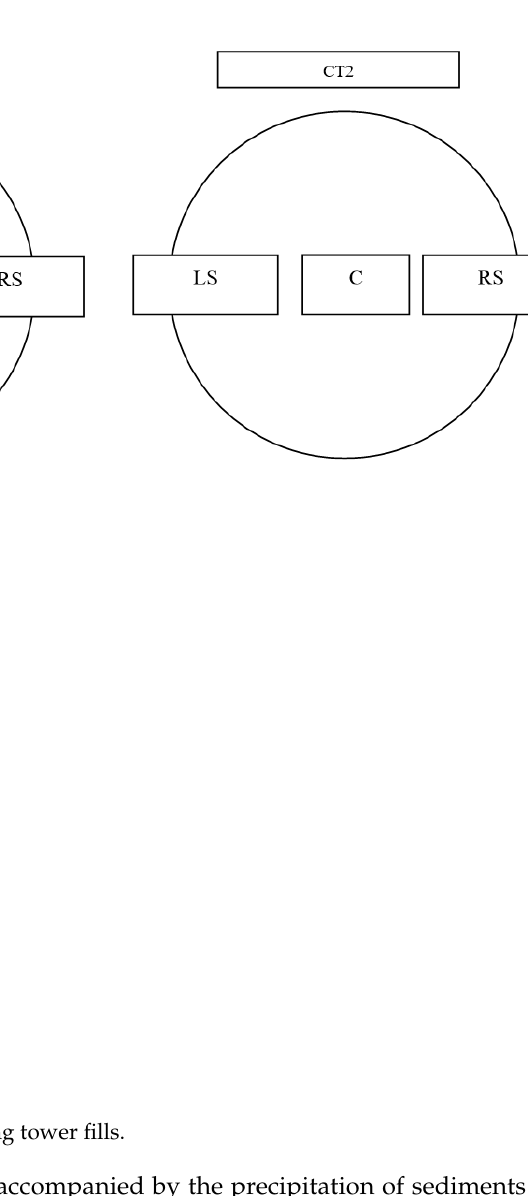
Figure 3. Working principles of cooling tower fills .